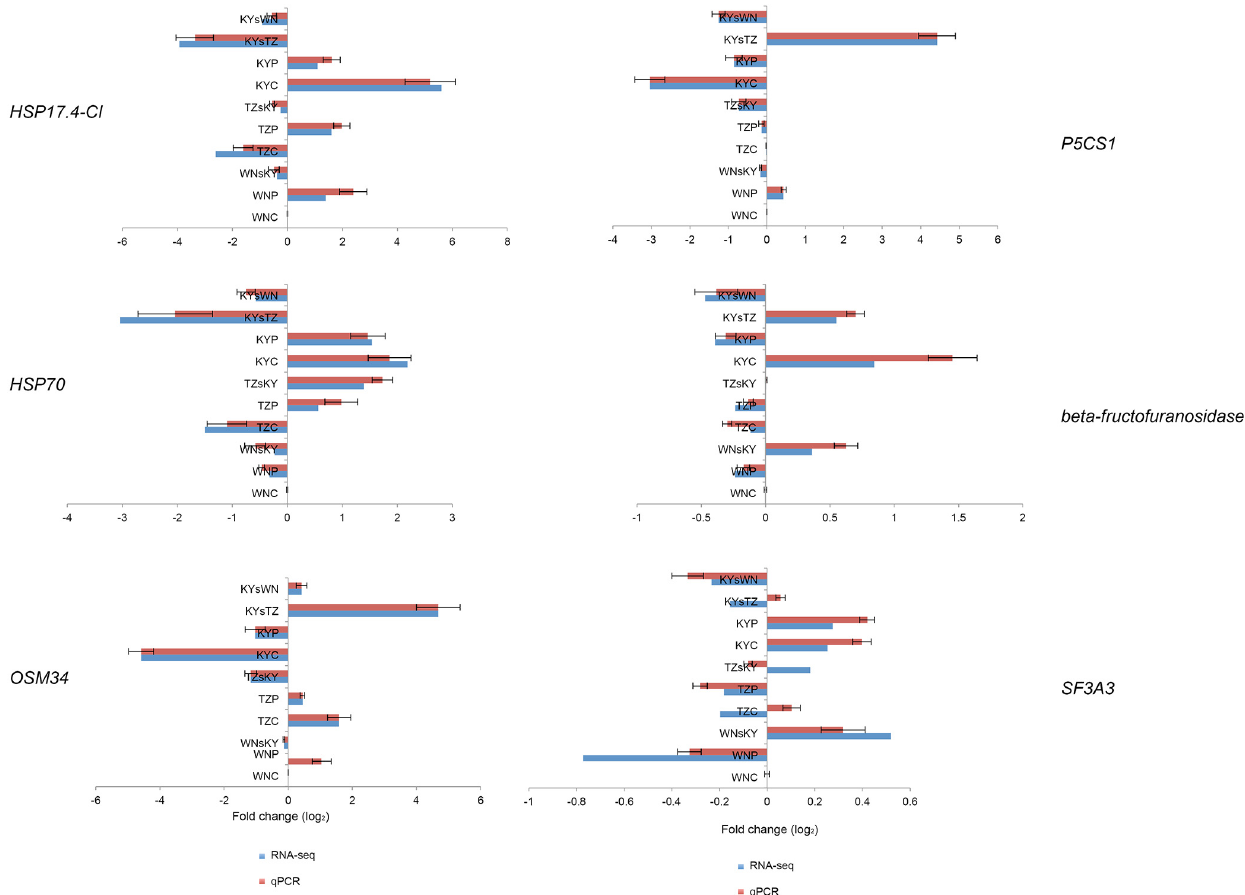
Figure 4. Correlation of differential expression between RNA-seq and qRT-PCR. Five DEGs and one non-DEG were chosen as differentially expressed by RNA-seq. The log -fold change of DEGs obtained from RNA-seq data (blue) versus log -fold 2 2 changes of qRT-PCR derived on the basis of expression levels for treatment (pink) averaged from three samples. All the log -fold changes were calculated using the 2 expression value of WNC as a calibrator. Error bars indicate